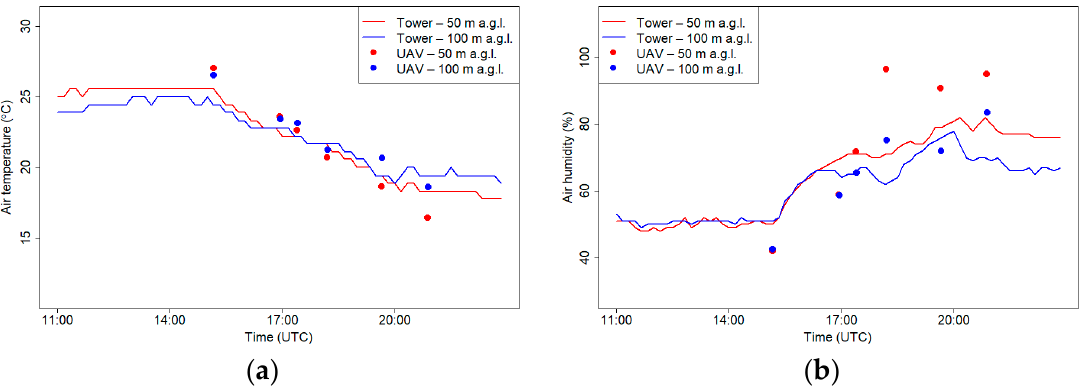
Figure 11. Air temperature ( a ) and relative humidity ( b ) at 50 and 100 m a.g.l. measured at the RTCN tower and by UAV